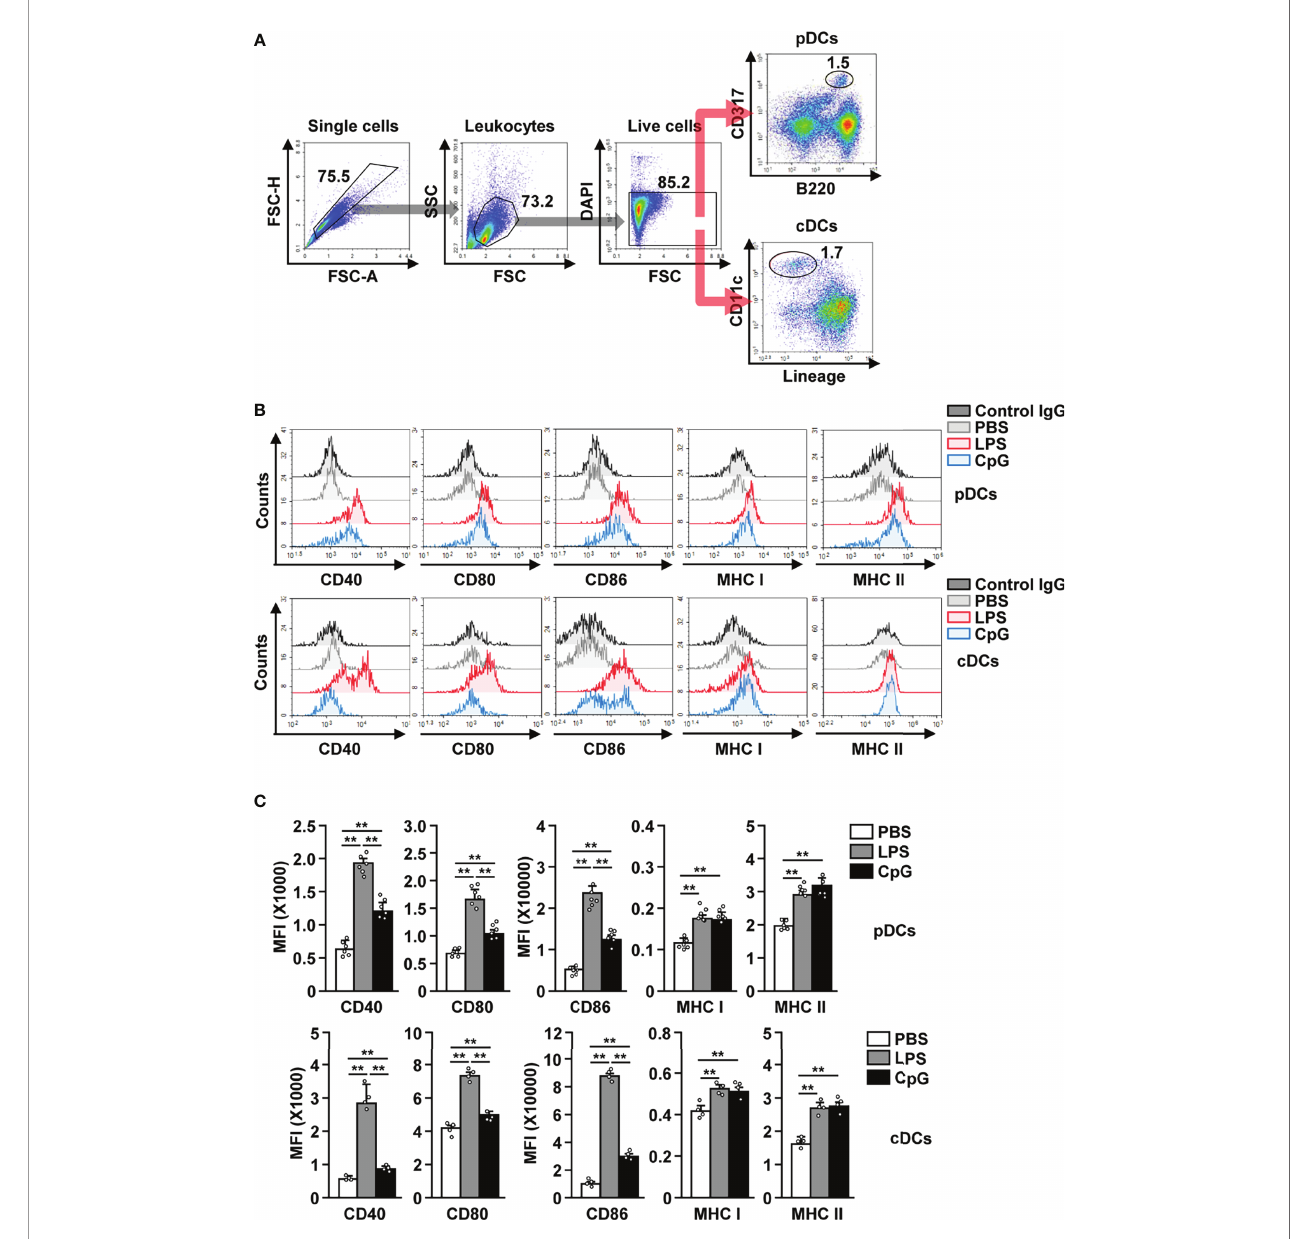
FIGURE 2 | LPS induced the activation of pDCs and cDCs in mice. C57BL/6 mice were treated intraperitoneally ( i.p. ) with 0.1 mg/kg LPS and 10 mg/kg CpG. The mice were sacri fi ced, and spleen was harvested 12 h after treatment. (A) Gating strategy for splenic pDCs and cDCs was shown. (B) CD40, CD80, CD86, and MHC class I and II expression levels in pDCs (upper panel) and cDCs (lower panel) were shown. (C) MFI of the indicated surface marker expression in pDCs (upper panel) and cDCs (lower panel) was shown (n = 6 mice, two-way ANOVA, mean±SEM, **p < 0.01